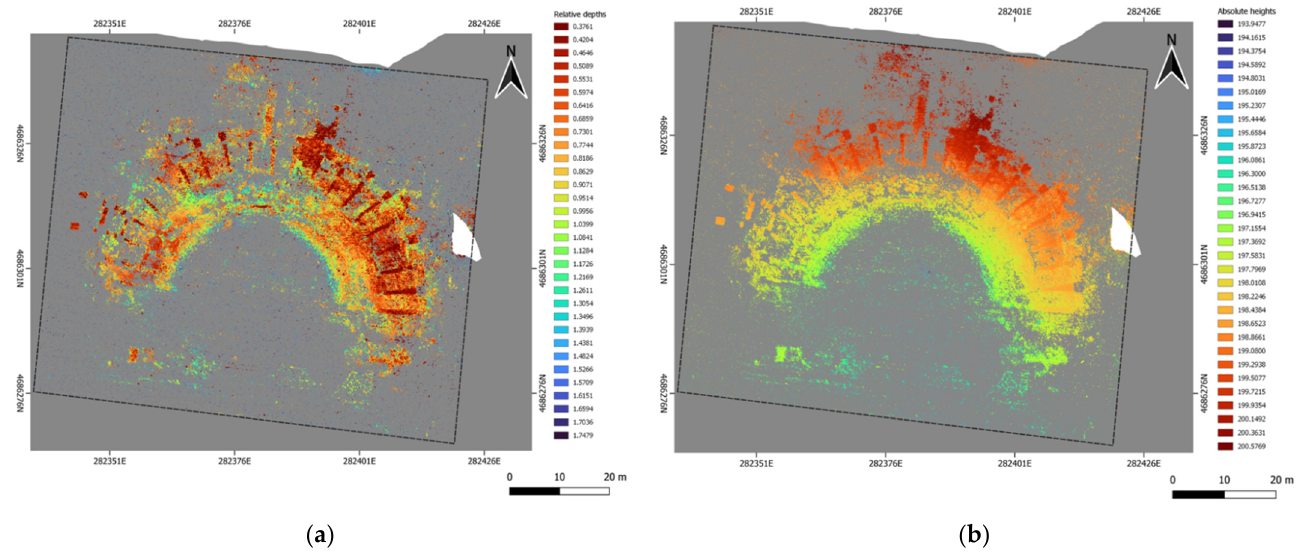
Figure 6. Results of plug-in application in the theater area: ( a ) “merged signal peaks map” with estimated depth value, ( b ) “buried feature elevation map”, in absolute height (image by M. Serpetti).